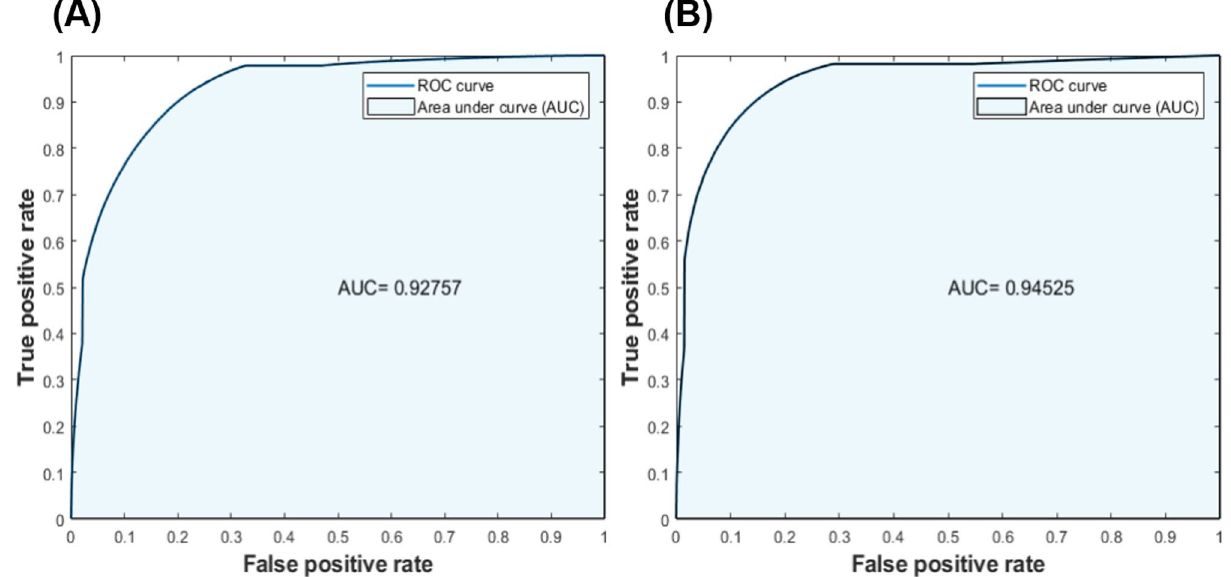
Figure 6. Receiver operating characteristic (ROC) and the area under the curve (AUC) for the calculated the performance of both classification models. These plots were conducted with respect to the true positive rate and false positive rate of the test set; ( A ) shows the ROC for the classification model1 and ( B ) shows the ROC for the classification model 2. The obtained results in both parts illustrate that both models had an acceptable performance in distinguishing the two different classes, with an AUC of 93% and 95%,